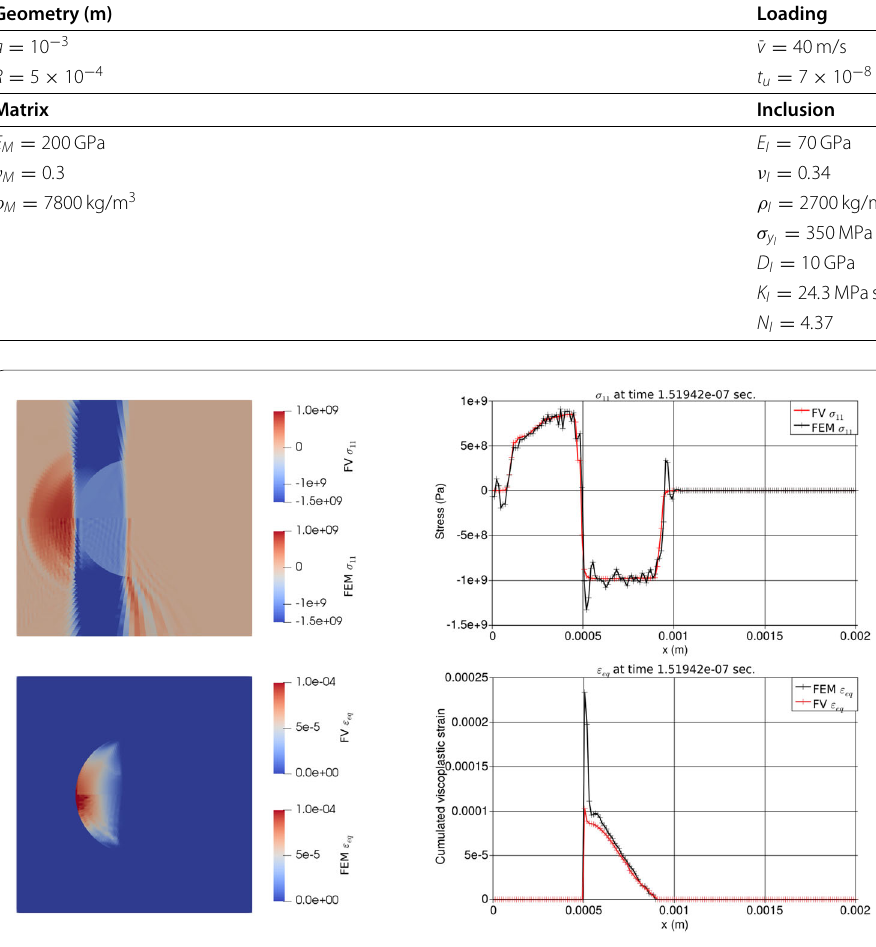
Fig. 19 Normal stress σ 11 and cumulated viscoplastic strains ε eq at time 1 . 52 × 10 − 7 s, computed with finite elements (bottom-half domain) and finite volumes (top-half domain). Superposed plots are made along the symmetry